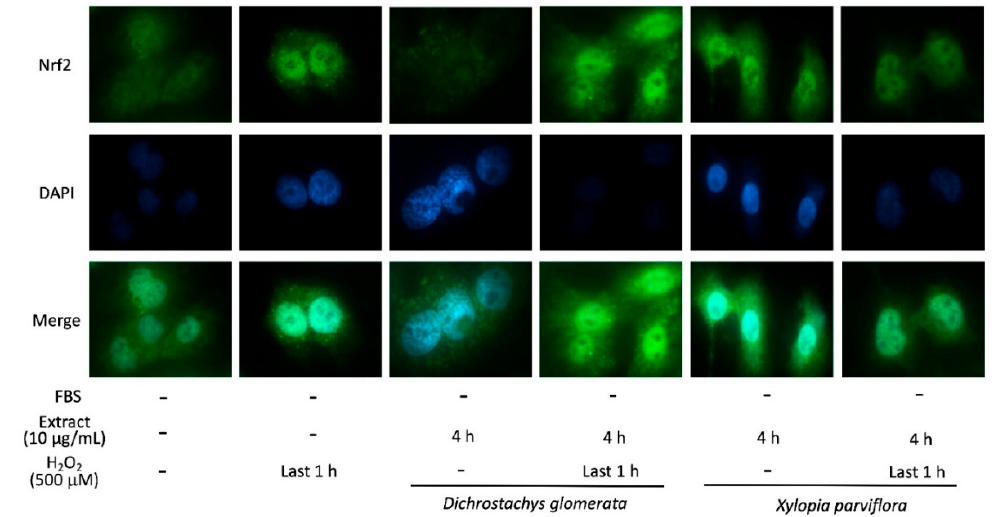
Figure 4. Effect of Dichrostachys glomerata and Xylopia parviflora extracts on Nrf2 nuclear translocation in HepG2 cells. Cells were treated with 10 μ g/mL spice extracts for 4 h; 500 μ M H 2 O 2 was added in the last hour. Nrf2 was detected with Alexa Fluor 488 F(ab’)2 fragment of anti-rabbit antibody; nuclei were counterstained with 4 ′ ,6-diamidino-2-phenylindole dihydrochloride (DAPI). Images are representative of three separate observations.